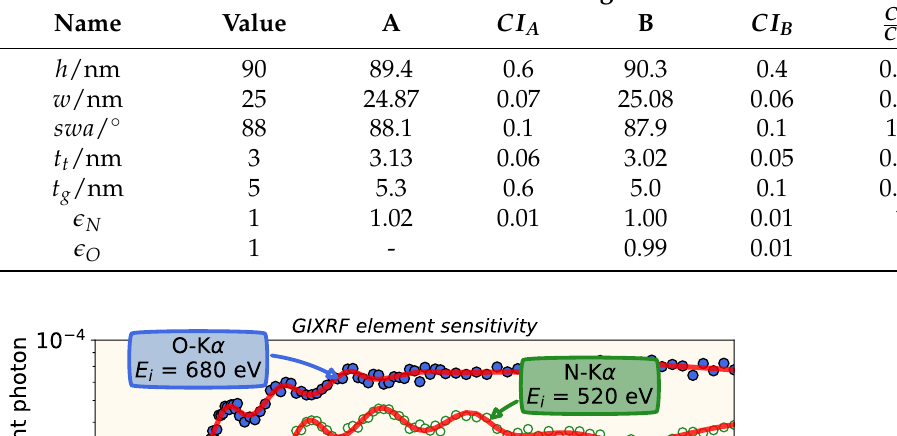
Table 1. The values of the geometrical parameters of the synthetic data from the GIXRF BO recon- struction with the model parameter confidence intervals ( CI ) for E i = 520 eV (Configuration A, only the nitrogen signal is modeled) and E i = 680 eV (Configuration B, both nitrogen and oxygen signals are modeled). The pitch was set to p = 50 nm. (height h , width w , sidewall angle swa , oxide layer in the groove t g , and oxide layer on the grating line t t ) Parameter Intial Config.